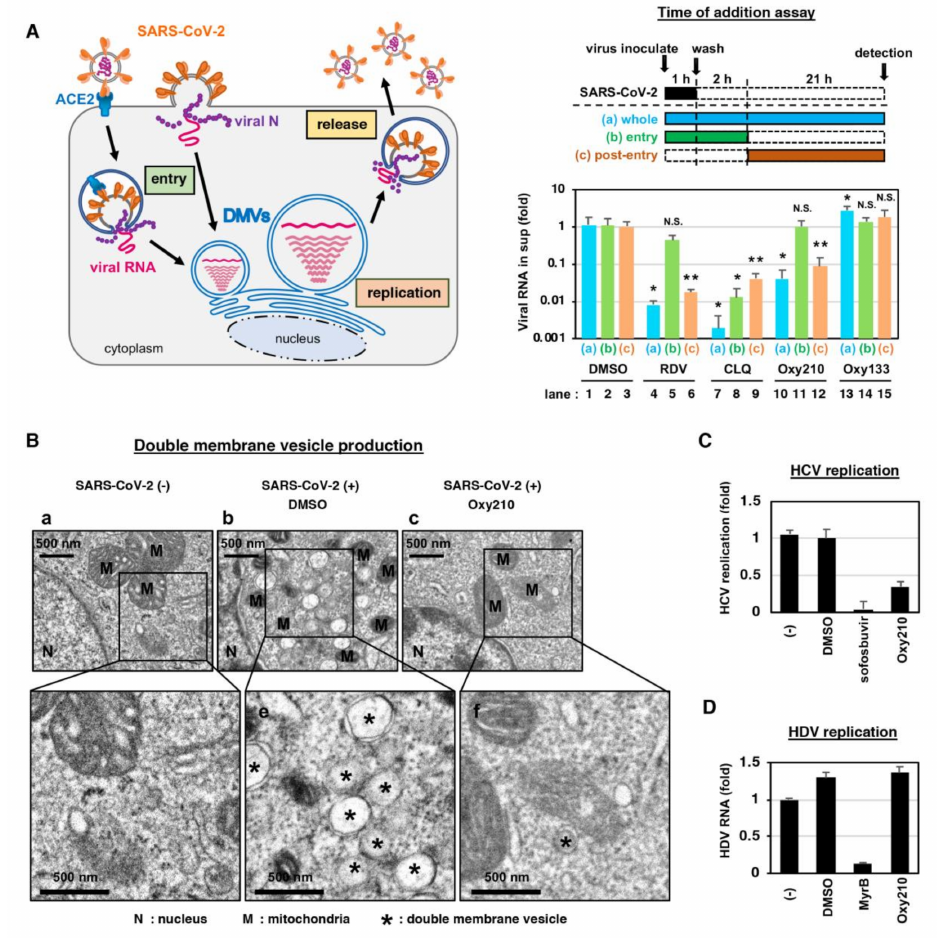
Figure 3. Oxy210 inhibits the SARS-CoV-2 genome replication. ( A ) Determination of the target step of compounds in the SARS-CoV-2 life cycle using time of additional analysis. The left diagram shows the life cycle of SARS-CoV-2, including the steps for viral entry, replication, and release. The upper right diagram shows the experimental procedures of the time of additional analysis. The assay was performed under three different conditions (a, whole; b, entry; c, post-entry): (a) the cells were treated with the compounds for 24 h throughout the whole procedure (whole life cycle); (b) compounds were added during the 1 h virus inoculation and then removed after an additional 2 h treatment (entry); (c) compounds were added at 2 h post-inoculation and presented for the remaining 21 h until harvest (post-entry). Solid and dashed boxes indicate the periods of presence and absence of the compounds, respectively. The lower right graph shows the real-time RT-PCR quantified viral RNA produced from the cells treated with 15 µ M RDV, 15 µ M CLQ, 10 µ M Oxy210, or 10 µ M Oxy133 under the three experimental conditions. All data are shown with error bars indicating S.D., * p < 0.05 vs. DMSO; ** p < 0.01 vs. DMSO; N.S., not significant; with Student’s t -test. ( B ) SARS-CoV-2 infected (panel b,c) or uninfected (panel a) cells were treated with the compounds (b, DMSO; c, 10 µ M Oxy210) as indicated and examined with electron microscopy. Images in panels d–f show the insets in panels a–c, respectively, at higher magnification. N, nucleus; M, mitochondria; *, double-membrane vesicle. ( C ) Hepatitis C virus (HCV) replication was evaluated by measuring the luciferase activity in LucNeo#2 cells carrying the discistronic HCV NN (genotype-1b) subgenomic replicon RNA and the luciferase gene (see Materials and Methods), treated with or without DMSO, 10 µ M Oxy210, or 1 µ M sofosbuvir as a positive control for 48 h. ( D ) Hepatitis D virus (HDV) replication was measured by quantifying HDV RNA using real-time RT-PCR in HepG2-hNTCP-C4 cells infected with HDV and treated with or without DMSO or 10 µ M Oxy210 for six days. 200 nM myrcludex-B (MyrB) was used as a positive control to inhibit HDV